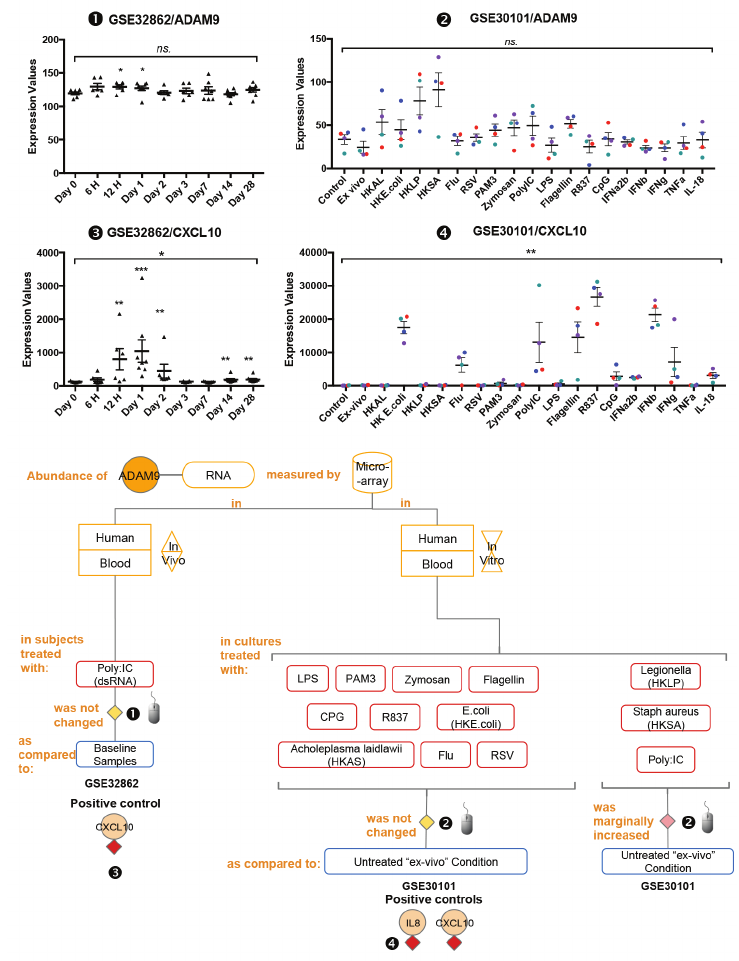
Figure 3. The abundance of ADAM9 increases only marginally following treatment with pathogen-associated molecules. mRNA expression levels for ADAM9 and CXCL10 were measured by microarrays in whole blood obtained from 8 healthy volunteers following sub- cutaneous administration of synthetic dsRNA (poly:IC) or placebo at baseline (day 0) and at 6 and 12 hours and 1, 2, 3, 7, 14, and 28 days (GSE32862), and from 4 healthy individuals(shown indifferent colors; Red, blue, green and purple) and stimulated in vitro for 6 hours with